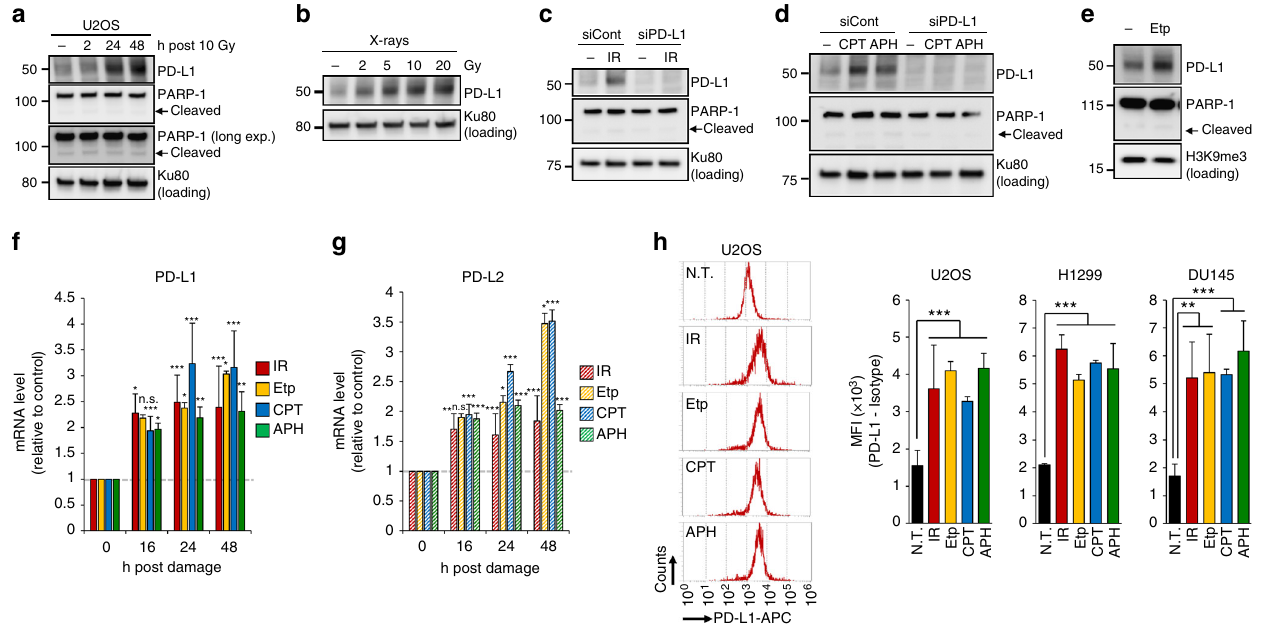
Fig. 1 DNA damage upregulates PD-L1 expression in cancer cells. a PD-L1 was upregulated after IR. PD-L1 expression in U2OS cells was examined 2, 24 and 48 h after 10 Gy. No substantial PARP-1 cleavage was observed during the analysis, suggesting that PD-L1 upregulation was not caused by apoptosis. b PD- L1 was upregulated in an IR-dose dependent manner. PD-L1 in U2OS cells was examined at 48 h after 2, 5, 10 and 20 Gy. c Depletion of PD-L1 by siRNA in U2OS cells veri fi ed that the signal detected at 48 h after 10 Gy X-rays was PD-L1. d PD-L1 was upregulated after exposure to DNA-damaging agents. U2OS cells were treated with 50 nM CPT or 500 nM APH. PD-L1 was examined 48 h after the treatment. e PD-L1 was upregulated after exposure to Etp. U2OS cells were treated with 500 nM Etp. PD-L1 was examined 48 h after treatment. f , g DNA damage upregulates PD-L1 and PD-L2 mRNA expression. U2OS cells were irradiated at 10 Gy, or were treated with 500 nM Etp, 50 nM CPT or 500 nM APH. PD-L1 or PD-L2 mRNA was examined at the indicated time points. Statistical signi fi cance was examined compared with non-treated cells. h Cell-surface expression of PD-L1 was examined by using fl ow cytometry. Cell-surface PD-L1 in U2OS, H1299 and DU145 cells was measured 48 h after 10 Gy, 500 nM Etp, 50 nM CPT or 500 nM APH treatment. A representative histogram is shown in left panel. N.T. non-treatment. Error bars represent the s.d. of three independent experiments ( f – h ). Statistical signi fi cance was determined using Student ’ s two-tailed t -test. * P < 0.05, ** P < 0.01, *** P <